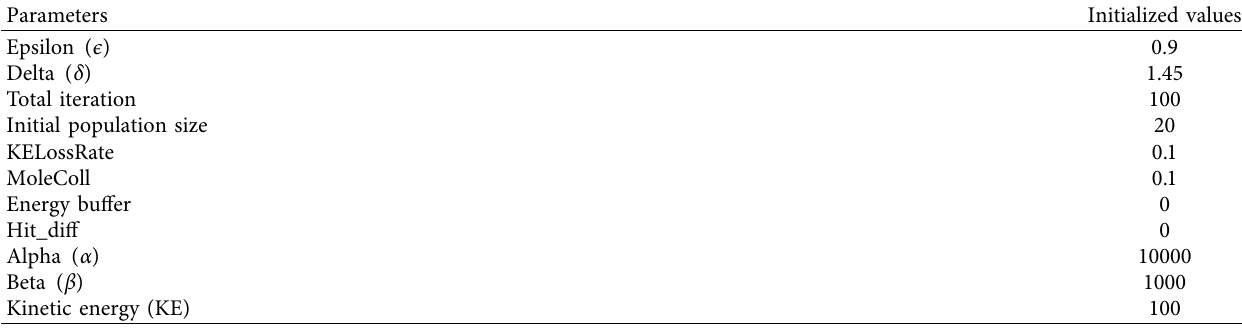
Table 2: Initialization of parameters for proposed MWDS_CRO